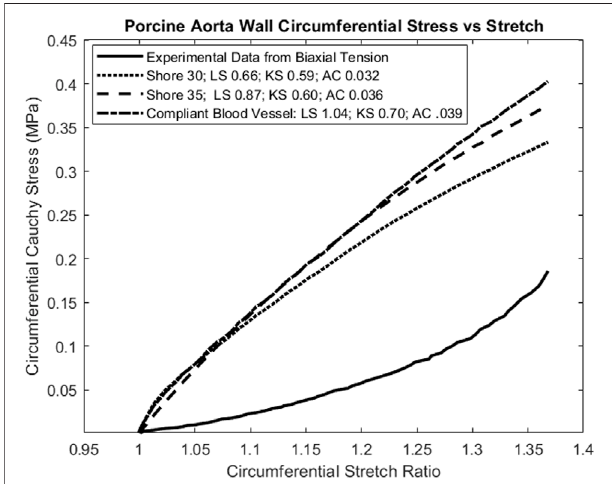
FIGURE 8 | Calculation of tissue matching parameters for stress-strain elastic curve of porcine aortic wall specimen (Polzer et al., 2015). Again, the lowest magnitudevaluesforall parameters agree,indicatingthattheShore 30 J750 material is closest matched to this aortic wall